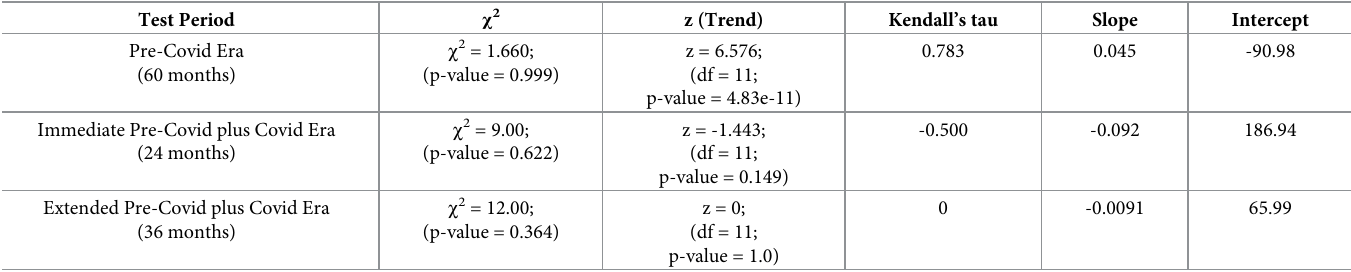
Table 2. Kendall seasonal trend test